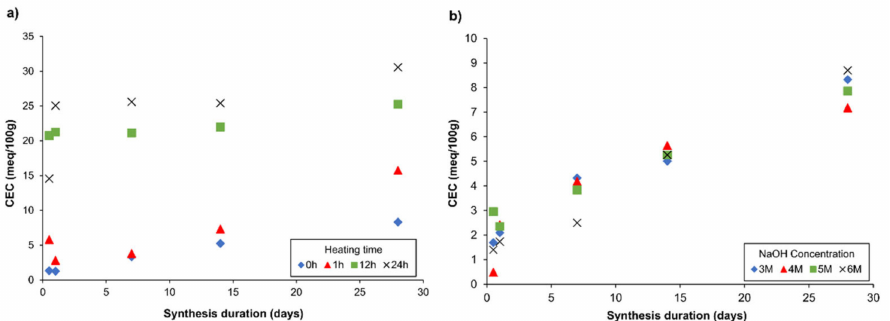
Figure 4. Influence of ( a ) heating time; ( b ) NaOH (DW) concentration on the cation exchange capacity (CEC)